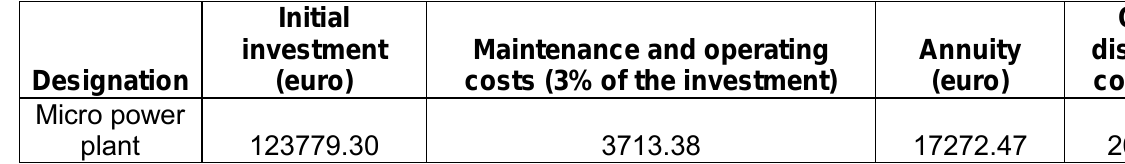
Table 3. Annual expenses of the micro wind power